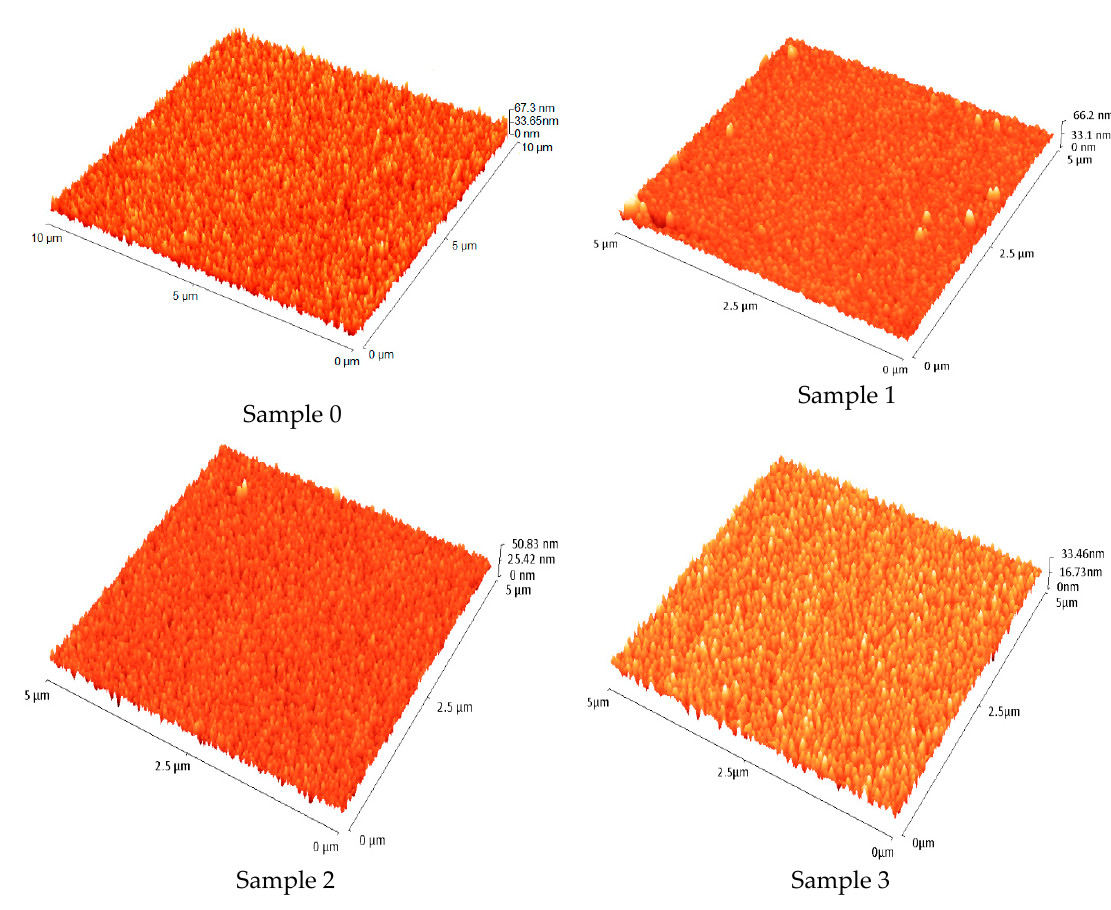
Figure 12. 3D AFM images of Samples 0–3.